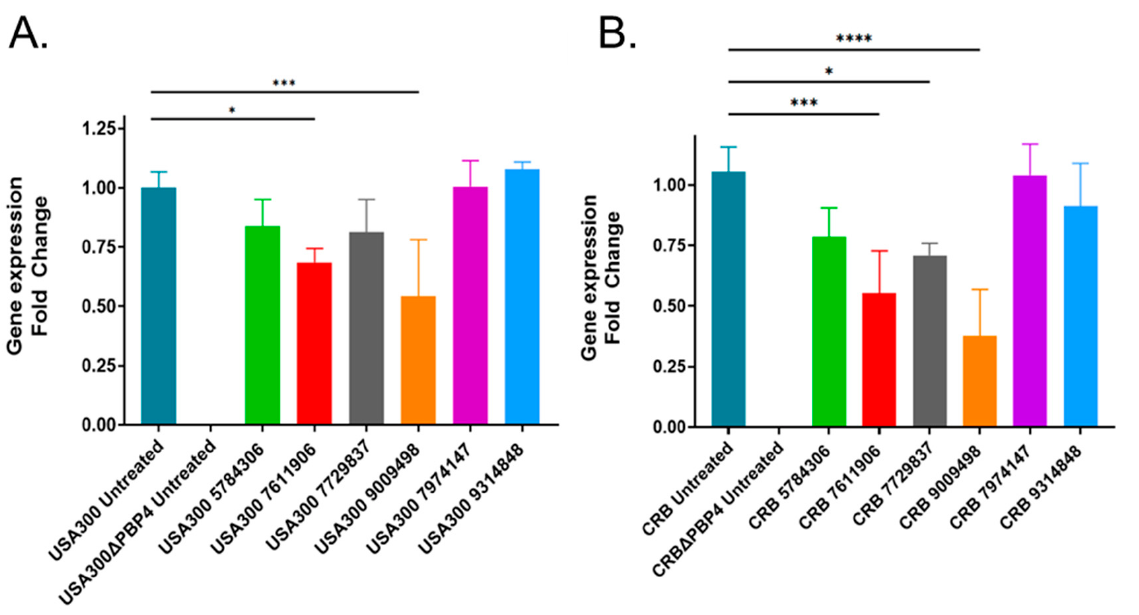
Figure 2. Effects of prioritized hits on S. aureus PBP4 expression. qRT-PCR measures of S. aureus strains USA300 (Panel ( A )) and CRB (Panel ( B )) pbp4 mRNA titers following treatment with 25 µM treatment of prioritized hits. Corresponding results for pbp4 -null strains shown; t -test (paired) p < 0.05 (*), p < 0.0005 (***), p < 0.0001 (****).